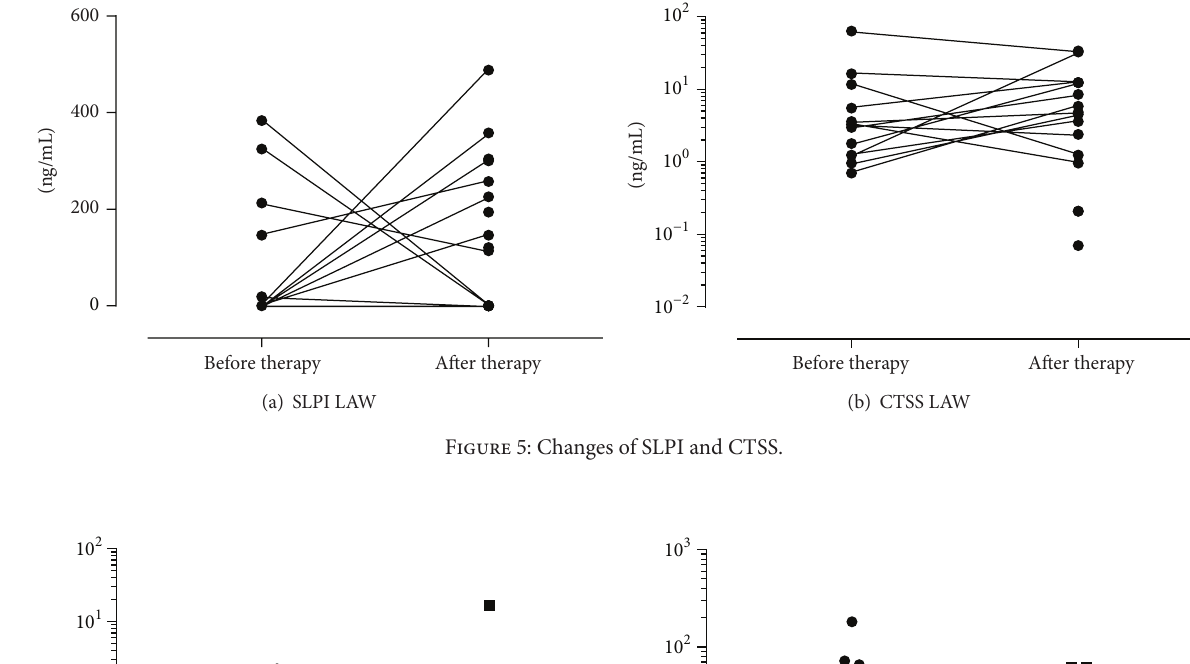
Figure 5: Changes of SLPI and CTSS.